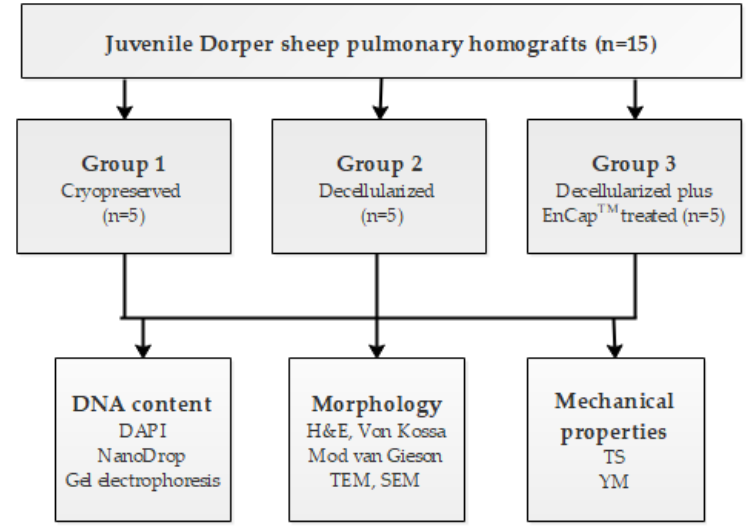
Figure 1. Schematic diagram of the study design.